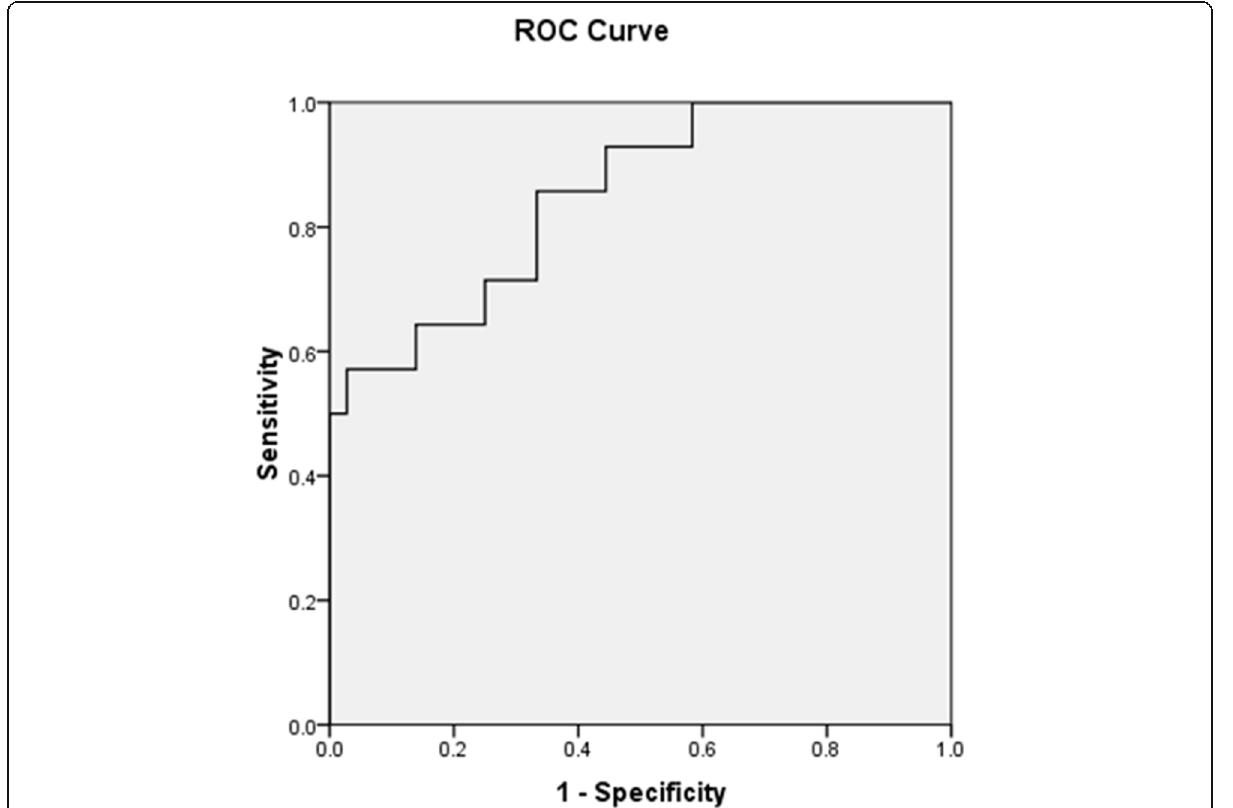
Fig. 2 ROC curve for prediction of cardio-embolic stroke using thioredoxin level on admission